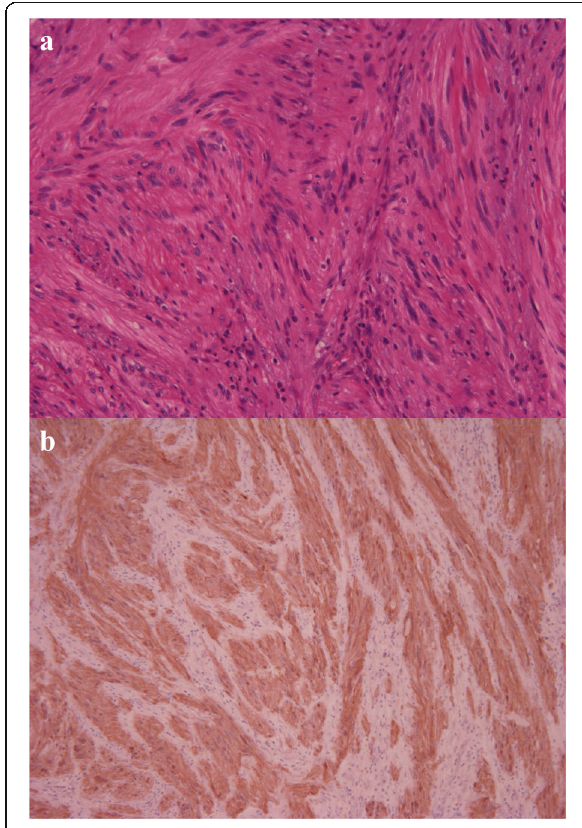
Fig. 6 Histologic appearance of the tumor. The tumor comprised a mixture of fibrillary collagen and cords of spindle cells with nodular growth ( a , × 50). Immunohistochemical staining results were positive for S-100 ( b , ×